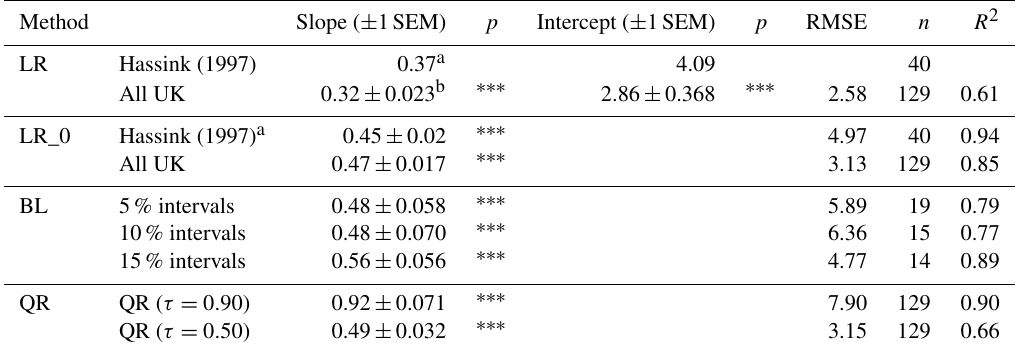
Table 3. Analysis coefficients for the estimation of maximum fine-fraction organic carbon by linear regression (LR), linear regression with a forced zero intercept (LR_0), boundary line (BL) and quantile regression (QR). Lettering indicates slopes that were significantly different within a method ( p < 0 . 05).